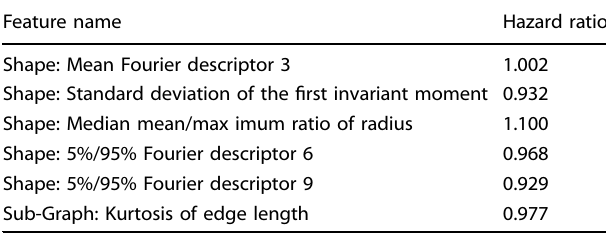
Fig. 2 Visualization of the sensitivity analysis experiment. a The fi rst fi ve boundary layers of a sample region of interest. In this panel, tissue outside of the original annotation was replaced with white background for clarity. b Results of removing an increasing number of boundary layers from the annotations of the validation set patients. The bars depict the fraction of patients who were originally Histotyping low/high- risk who changed to high-/low-risk after removing a given number of boundary layers. The dots show the c-index and 95% CI of Histotyping based on scores calculated after removing boundary layers. These results suggest that Histotyping is robust to variation in pathologist judgment on tumor boundary. Table 1. The set of 6 gland lumen features selected by the elastic-net Cox regression model as being most prognostic of BCR on the n = 214 patient training